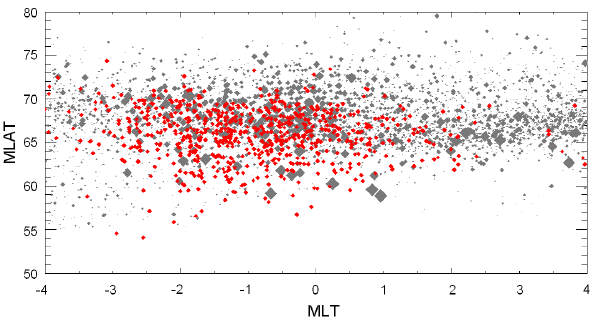
Fig. 1. Onset positions of the auroral emission events obtained us- ing the spatiotemporal detection method described in the text (grey color, symbol size proportional to event energy E ) superposed with the auroral substorm onsets (red) from the database by Frey et al.